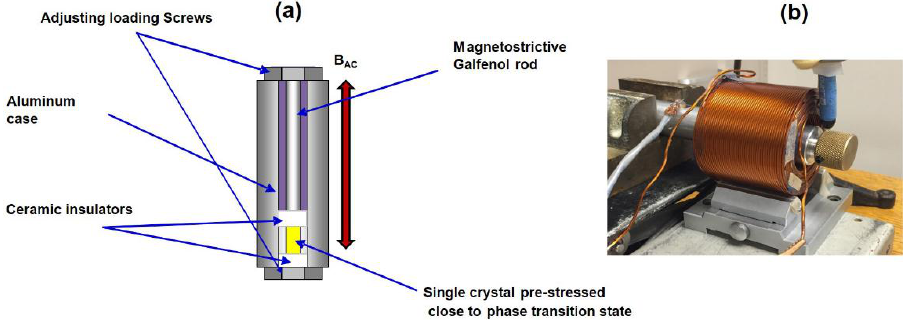
Figure 2. ( a ) Magnetoelectric harvester cross-section, showing the applied bipolar field direction. ( b ) Experimental setup showing the harvester in a solenoid coil.